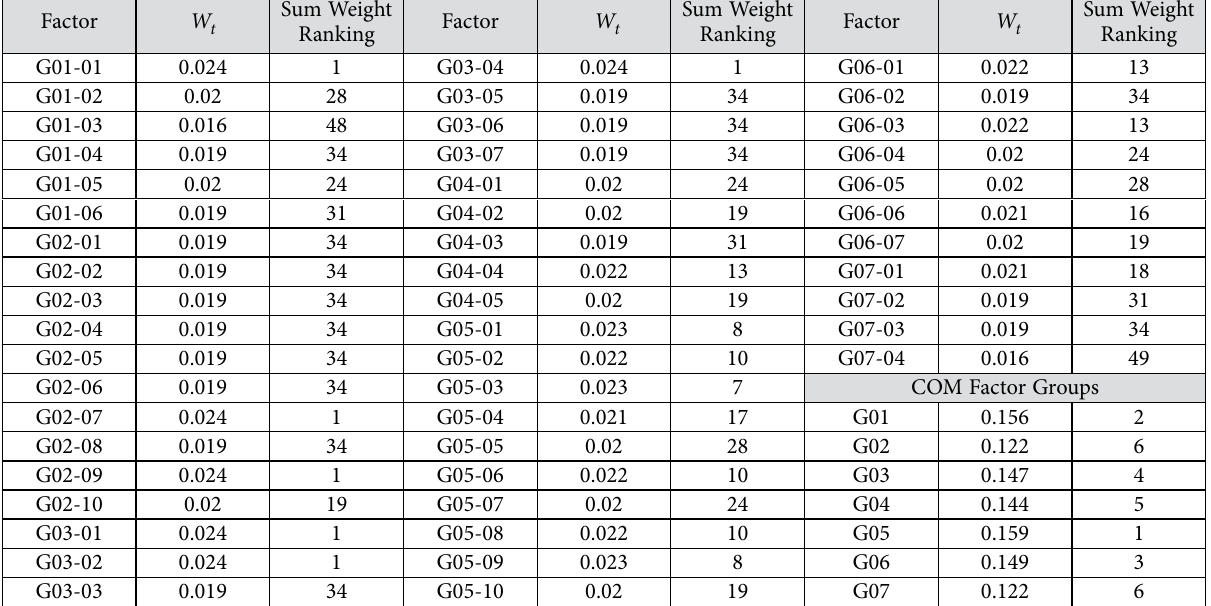
Table 8. Sum weights ranking for the COM factors and groups (second